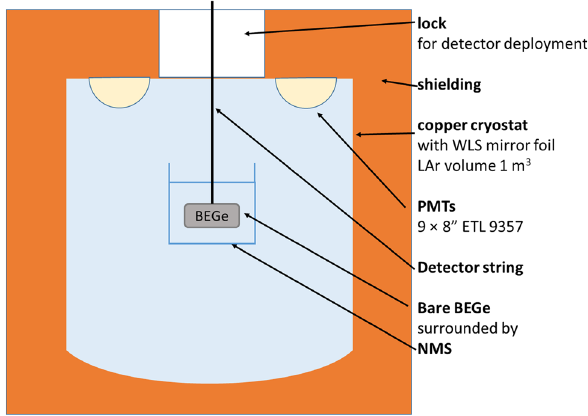
Fig. 6 Schematic view of the LArGe setup